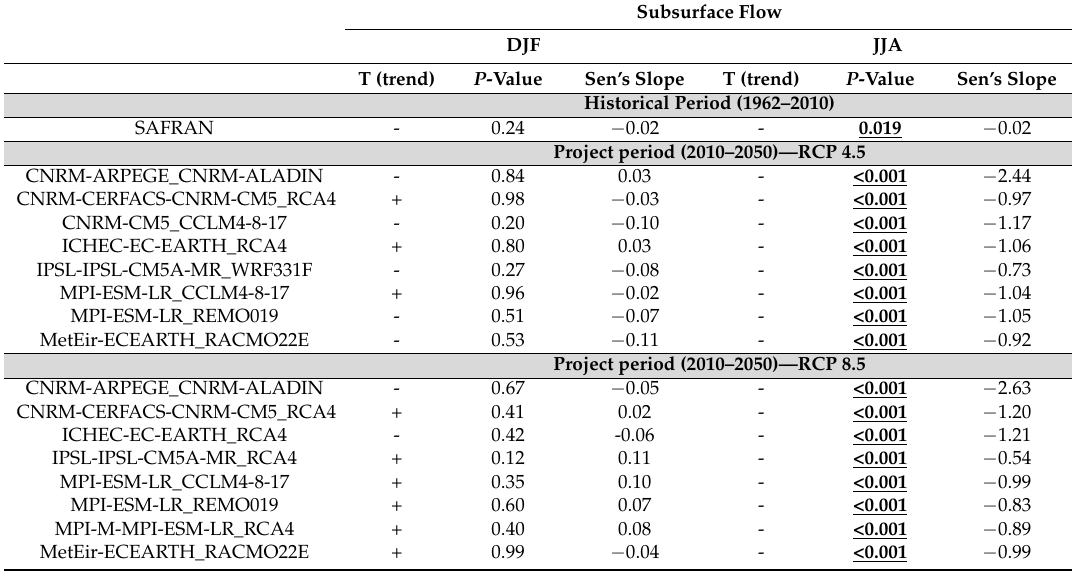
Table 10. Trend in subsurface flow over winter (DJF) and summer (JJA) seasons at watershed scale, for SAFRAN (historical period) and climatic ensemble (projected period). Bold numbers are significant trend considering α = 0.1 and underlined numbers considering α = 0.05.